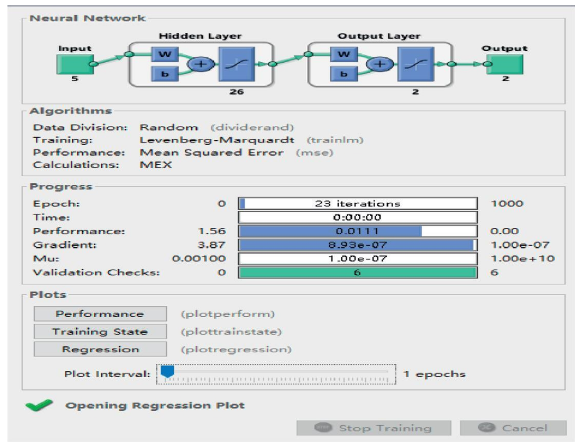
Figure 20: Training effect diagram.